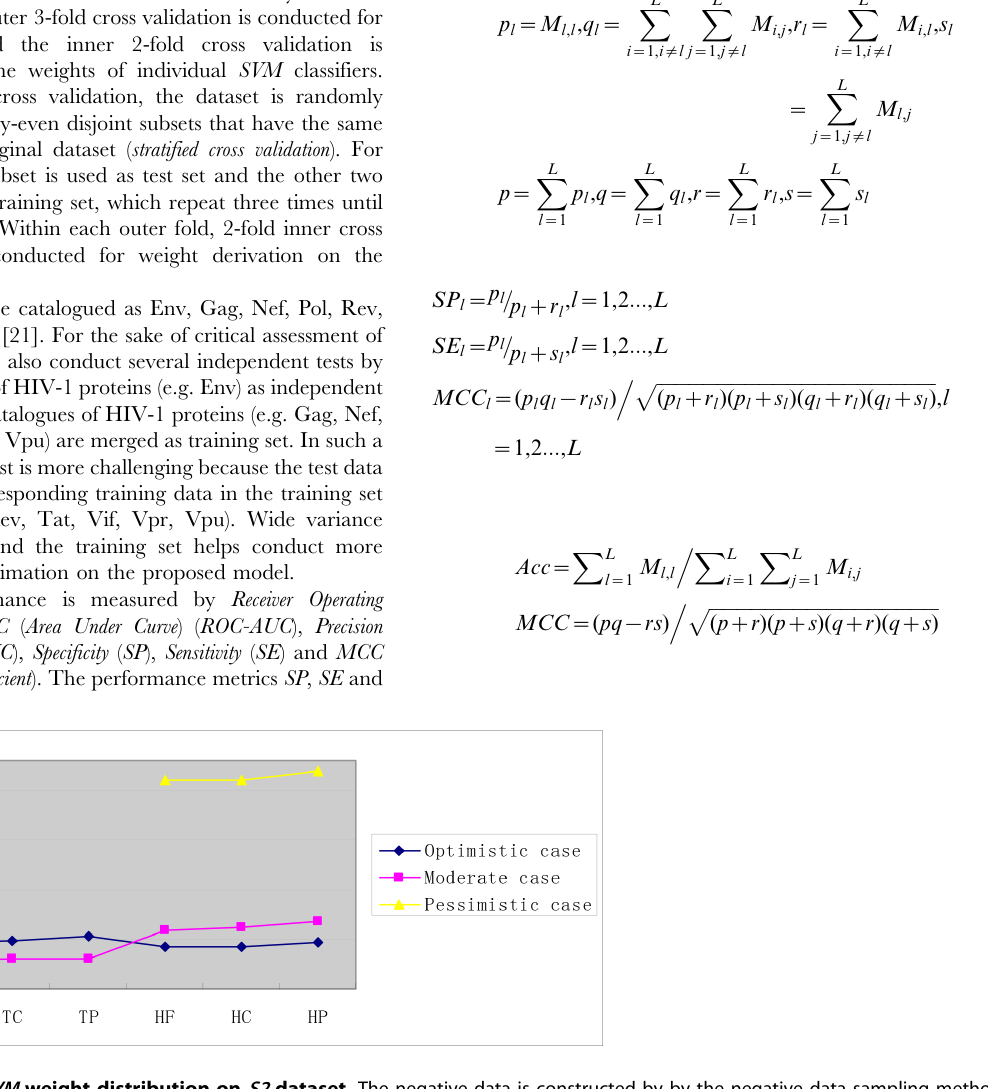
Figure 6. Individual SVM weight distribution on S2 dataset. The negative data is constructed by by the negative data sampling method of random sampling . The horizontal axis is the combination of two sets {T, H} and {F,C, P}. T denotes the target protein, H denotes the homolog protein; F denotes molecular function , C denotes cellular component and P denotes biological process . doi:10.1371/journal.pone.0079606.g006 PLOS ONE |